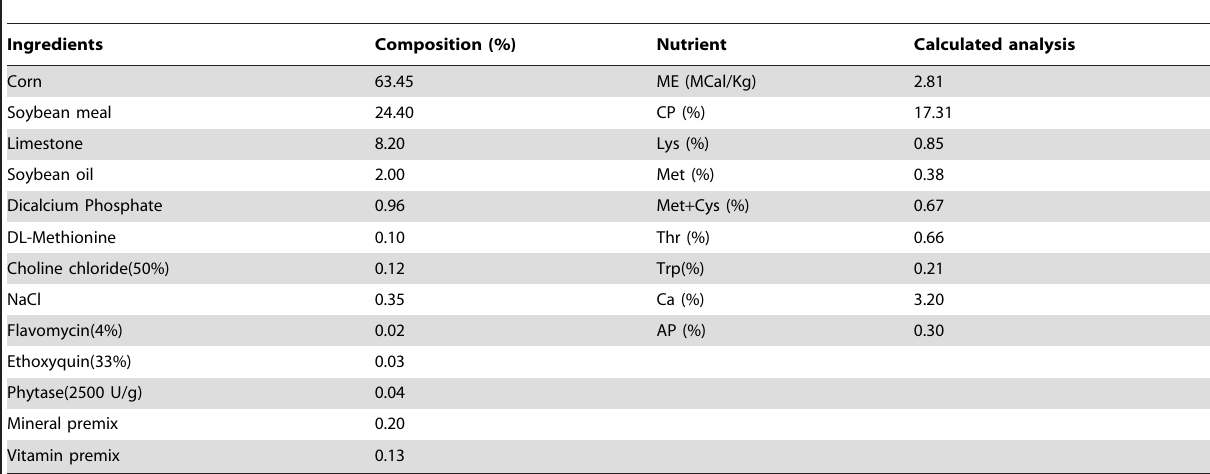
Table 1. Composition of diets and nutrient levels of broiler breeder experiment.